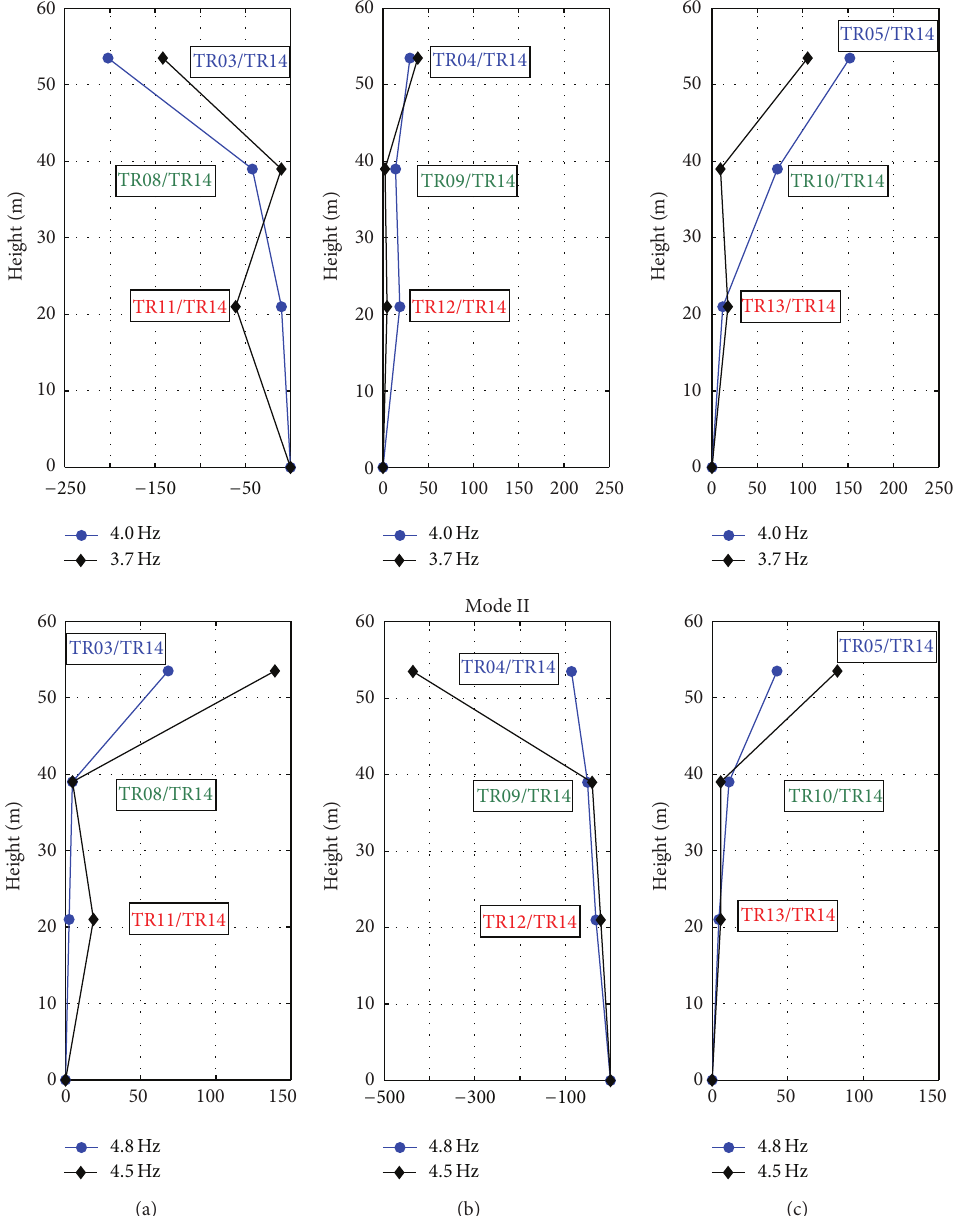
Figure 13: Comparison between the experimental mode shapes evaluated in terms of relative amplification effect, derived for: (a) the left side of the dam; (b) the crown cantilever vertical section; (c) the right side of the